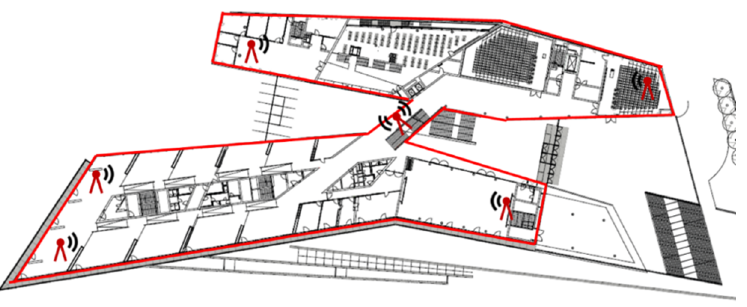
Figure 5. Concept drawing for an additional indoor antenna to evaluate the need of indoor units in different indoor environments.